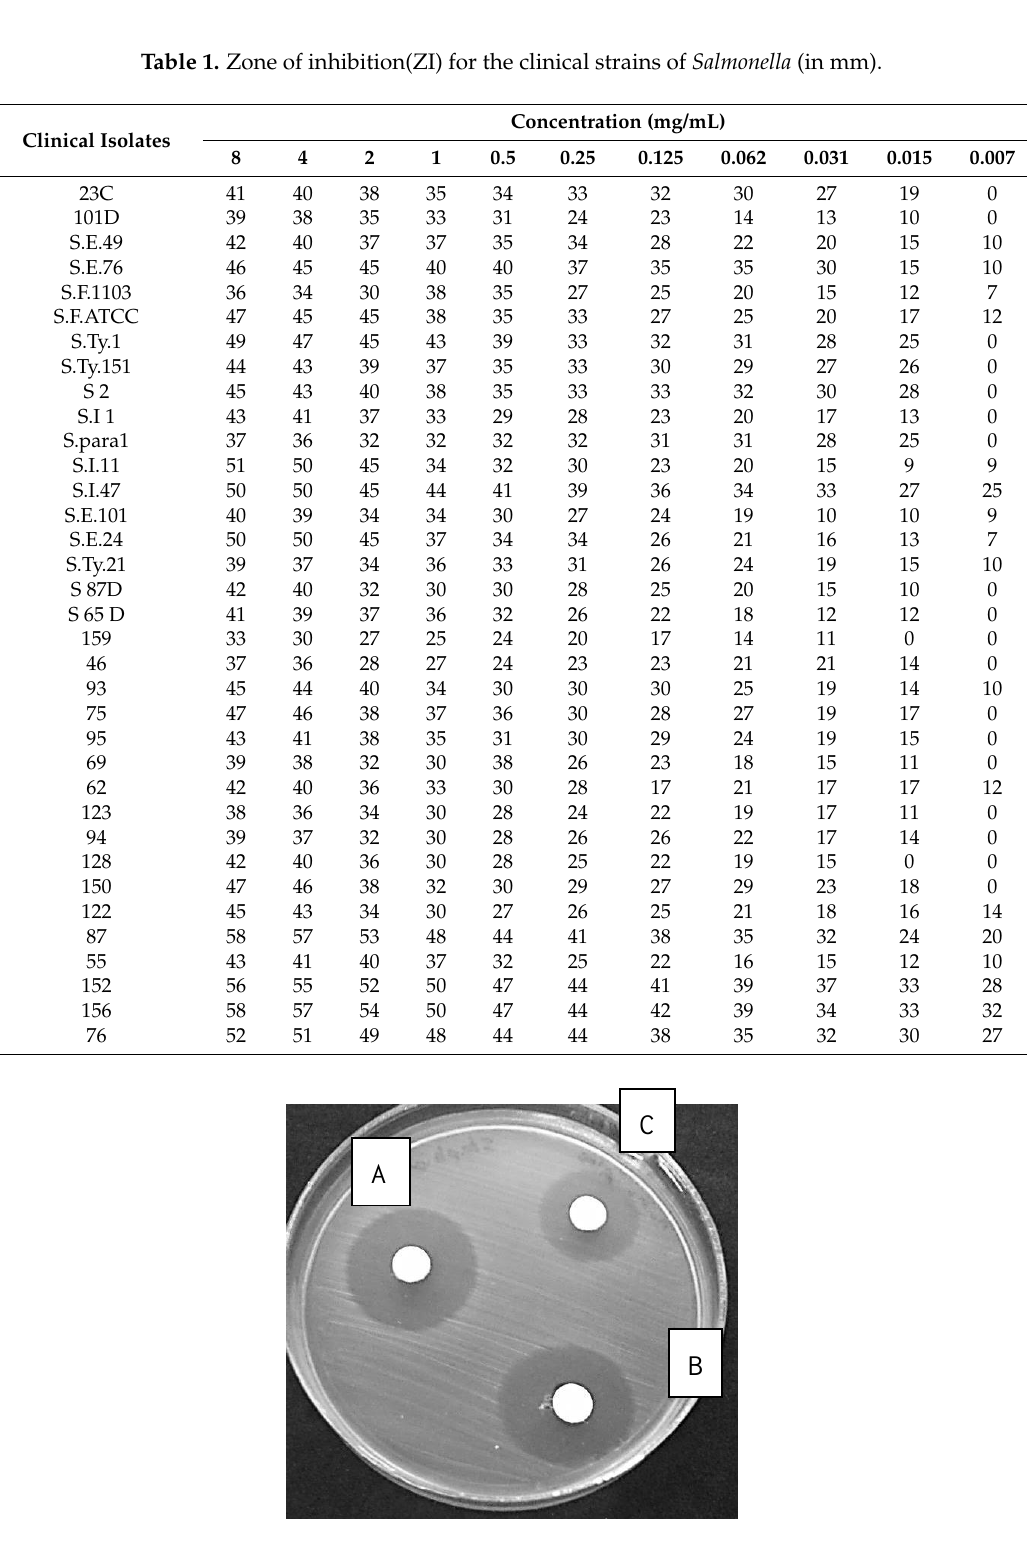
Table 1. Zone of inhibition(ZI) for the clinical strains of Salmonella (in mm).